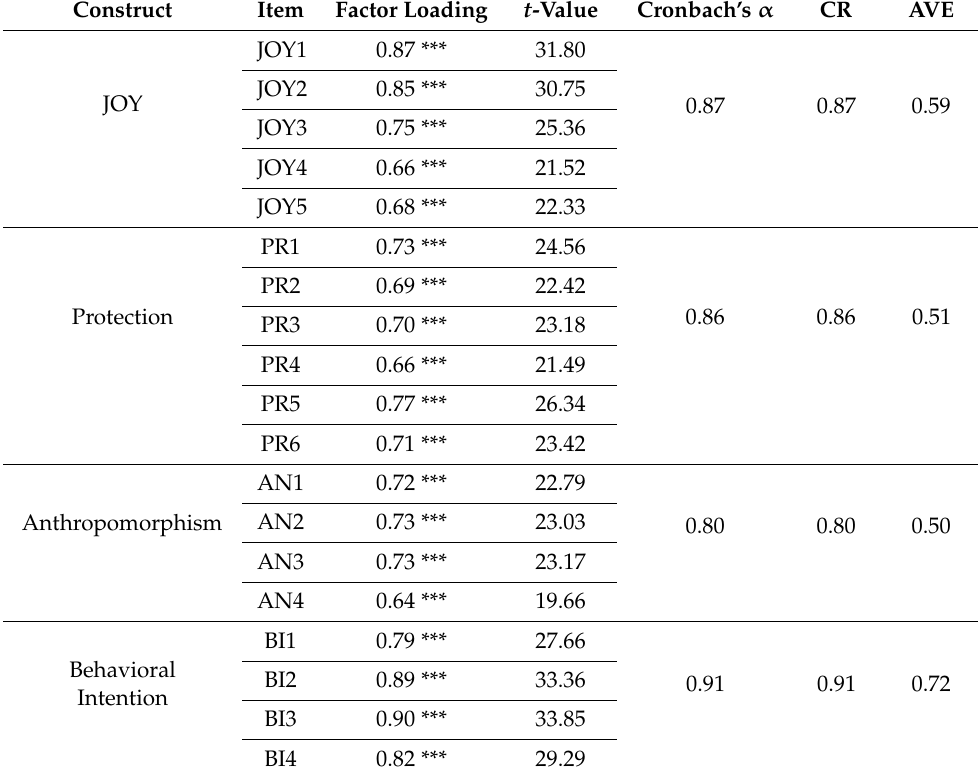
Table 8. Measurement accuracy analysis statistics (the second wave): factor loading and its t -value, Cronbach’s α value, composite reliability (CR), and average variance extracted (AVE). Construct Item t